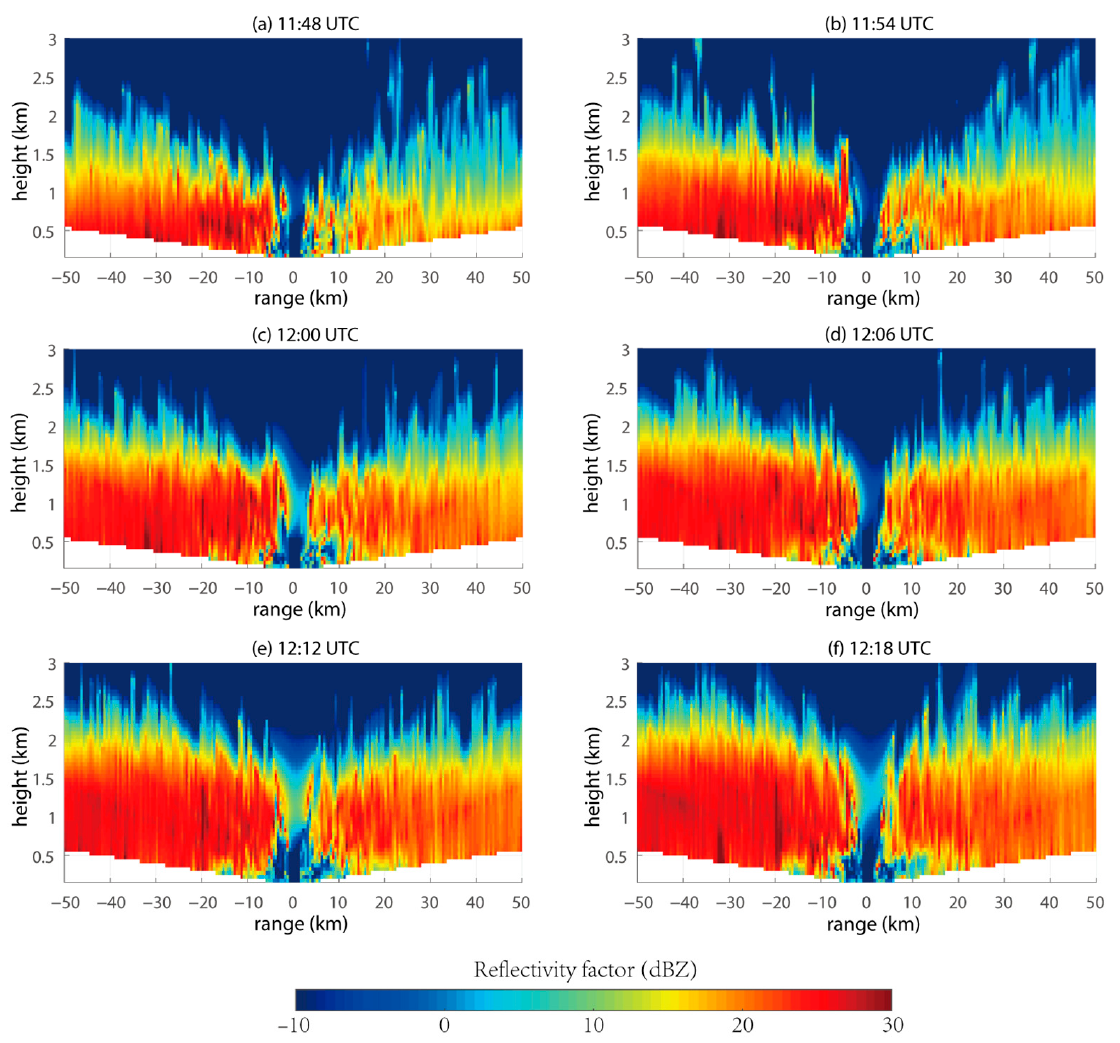
Figure 8. Range–height cross-section of 𝑍 following the azimuthal direction (azimuth: 225°). ( a – f ) Continuous observations from the CINRAD/SA at 6 min intervals from 11:48 to 12:28, 2 May 2021. The horizontal axis is the range (km) along the wind direction, and the vertical axis is the height (km).